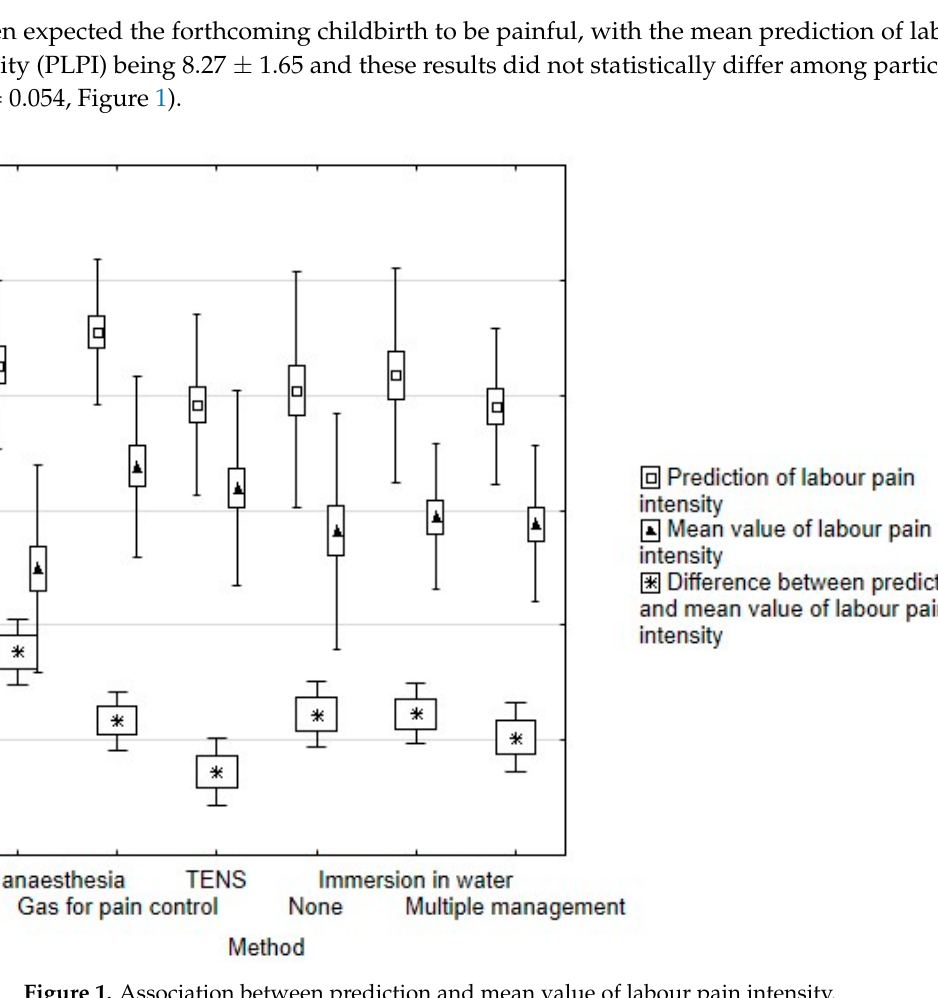
Table 1. Clinical characteristics of delivering women stratified by chosen pain relief method.